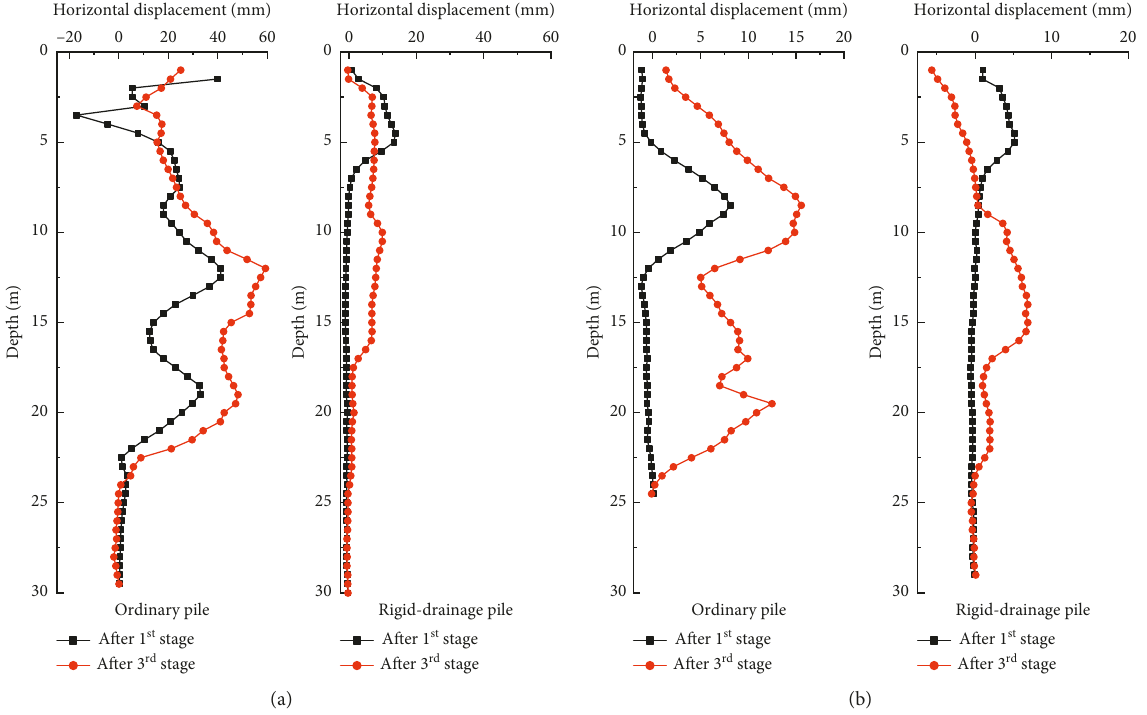
Figure 9: Curves of the horizontal soil displacements. At measuring points (a) 0.9m and (b) 1.8 m from the pile